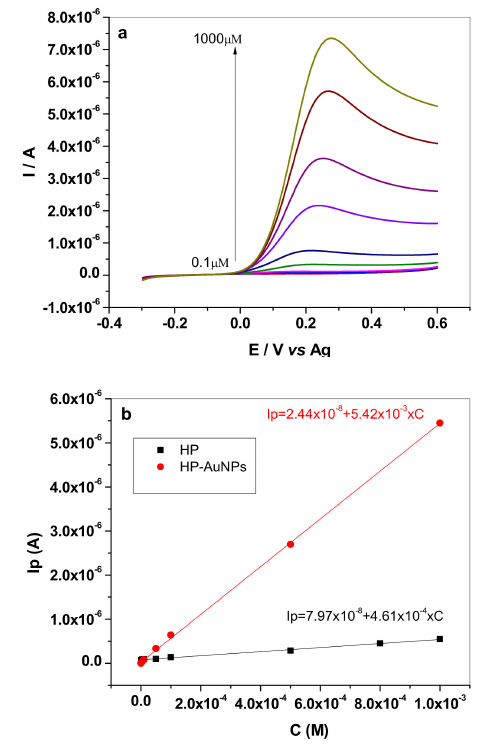
Figure 7. LSV recorded with HP-AuNPs electrode in pH 6 PBS solutions containing di ff erent concentrations of dopamine (10 − 7 –10 − 3 M); scan rate 10 mVs − 1 ( a ); the calibration curve for HP (10 − 6 –10 − 3 M DA) and HP-AuNPs (10 − 7 –10 − 3 M DA) electrode ( b